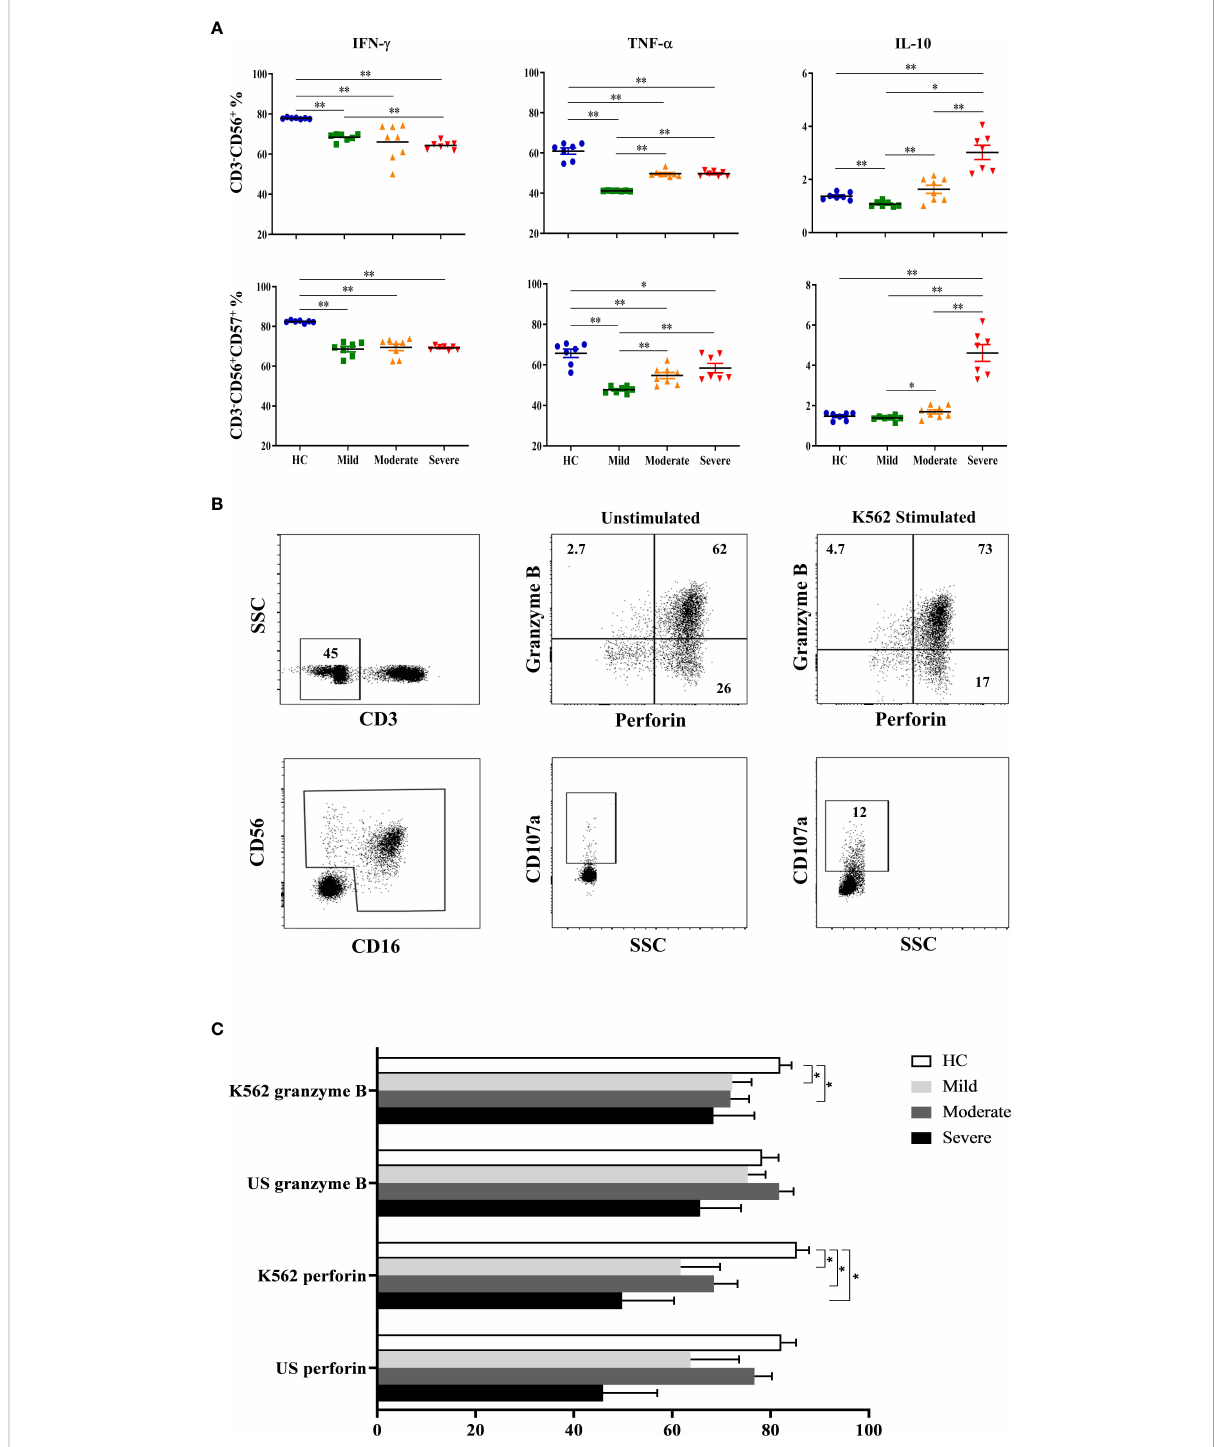
FIGURE 2 Intracellular cytokine levels and cytotoxic capacity of NK cells in COVID-19 patients. (A) IFN- g , TNF- a and IL-10 levels of CD3 − CD56 + and CD3 − CD56 + CD57 + NK cells. (B) To analyze the capacity of NK cell cytotoxicity, PBMCs were cultured with the absence and existence of K562 cells. Granzyme B, perforin and CD107a levels of NK cells were measured to evaluate the cytotoxicity. CD3 − CD16 + CD56 + cells were gated as total NK cells. Granzyme B, perforin and CD107a expression of total NK cells were shown in the representative fi gure. (C) Perforin and granzyme B expression levels of patients and healthy controls, at the presence and absence of K562 cells. *p<0.05. **p<0.001, HC, Healthy